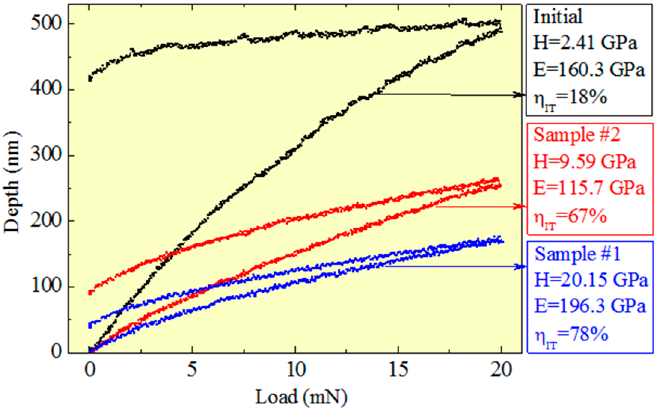
Figure 35. Test diagrams of the original and coated samples.